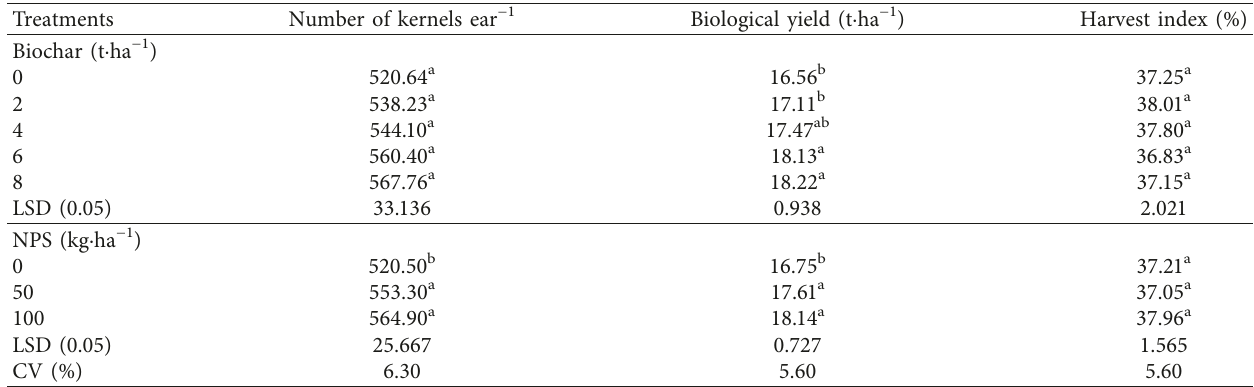
Table 6: The main effects of biochar levels and inorganic NPS fertilizer rates on number of kernel ear − 1 , biological yield (t · ha − 1 ), and harvest index (%) of maize at Guto Gida, Western Ethiopia.